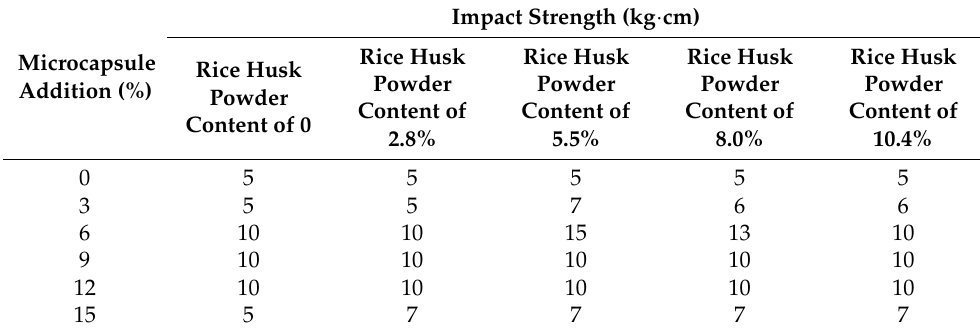
Table 11. Effect of microcapsule content on the impact resistance of waterborne primer coating.